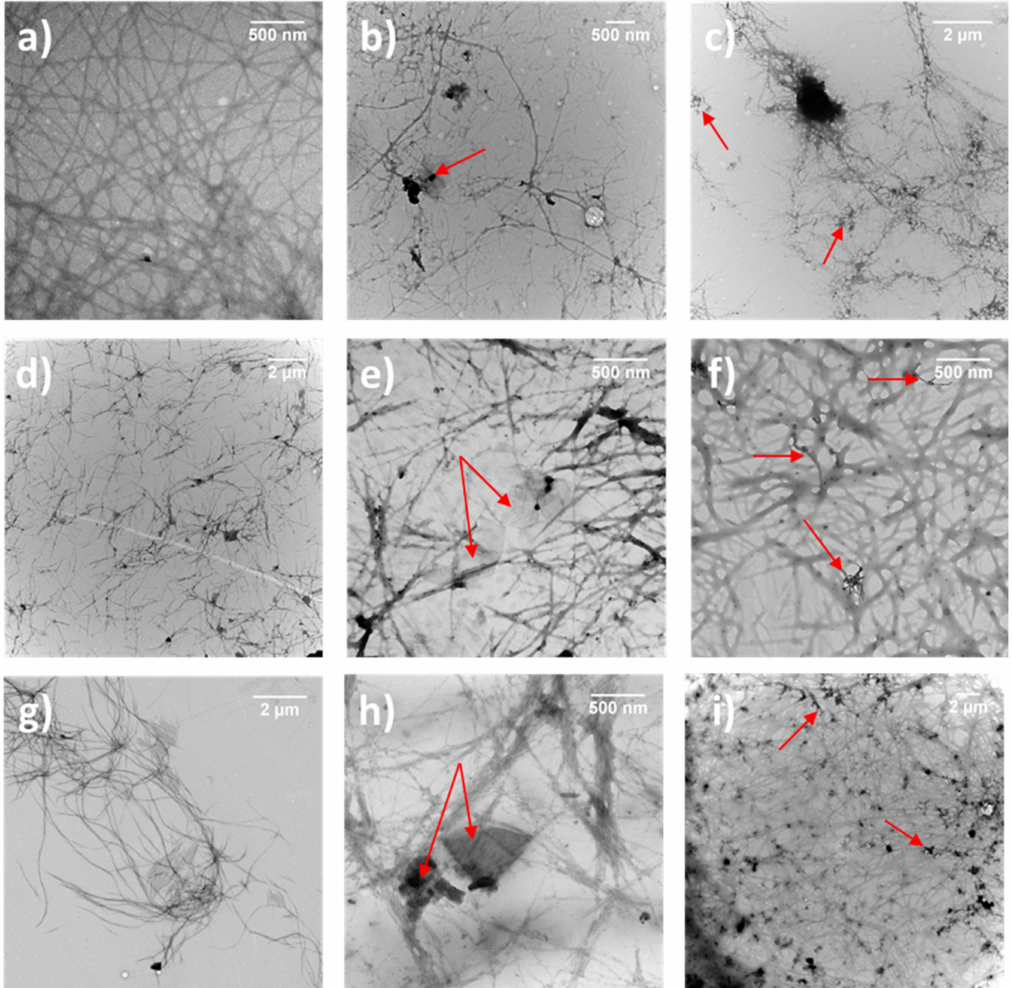
Figure 5. TEM images of ( a ) Boc- α ( S )Phe- α ( S )Phe-OH, ( b ) Boc- α ( S )Phe- α ( S )Phe-OH + 0.025 wt% GO, ( c ) Boc- α ( S )Phe- α ( S )Phe-OH + 0.025 wt% ox-CNTs, ( d ) Boc- β 3 ( R )Phe- β 3 ( R )Phe-OH, ( e ) Boc- β 3 ( R )Phe- β 3 ( R )Phe-OH + 0.025 wt% GO, ( f ) Boc- β 3 ( R )Phe- β 3 ( R )Phe-OH + 0.025 wt% ox-CNTs, ( g ) Boc- γ 4 ( R )Phe- γ 4 ( R )Phe-OH, ( h ) Boc- γ 4 ( R )Phe- γ 4 ( R )Phe-OH + 0.025 wt% GO, and ( i ) Boc- γ 4 ( R )Phe- γ 4 ( R )Phe-OH + 0.025 wt% ox-CNTs. The arrows show GO sheets and